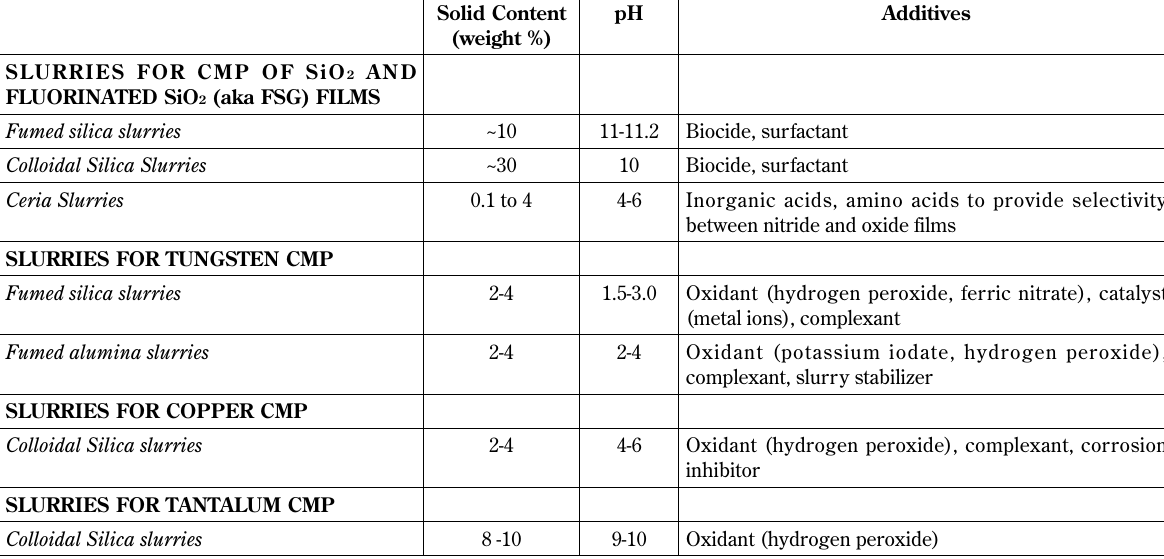
Table 1 Comparison of the characteristics of typical slurries used in